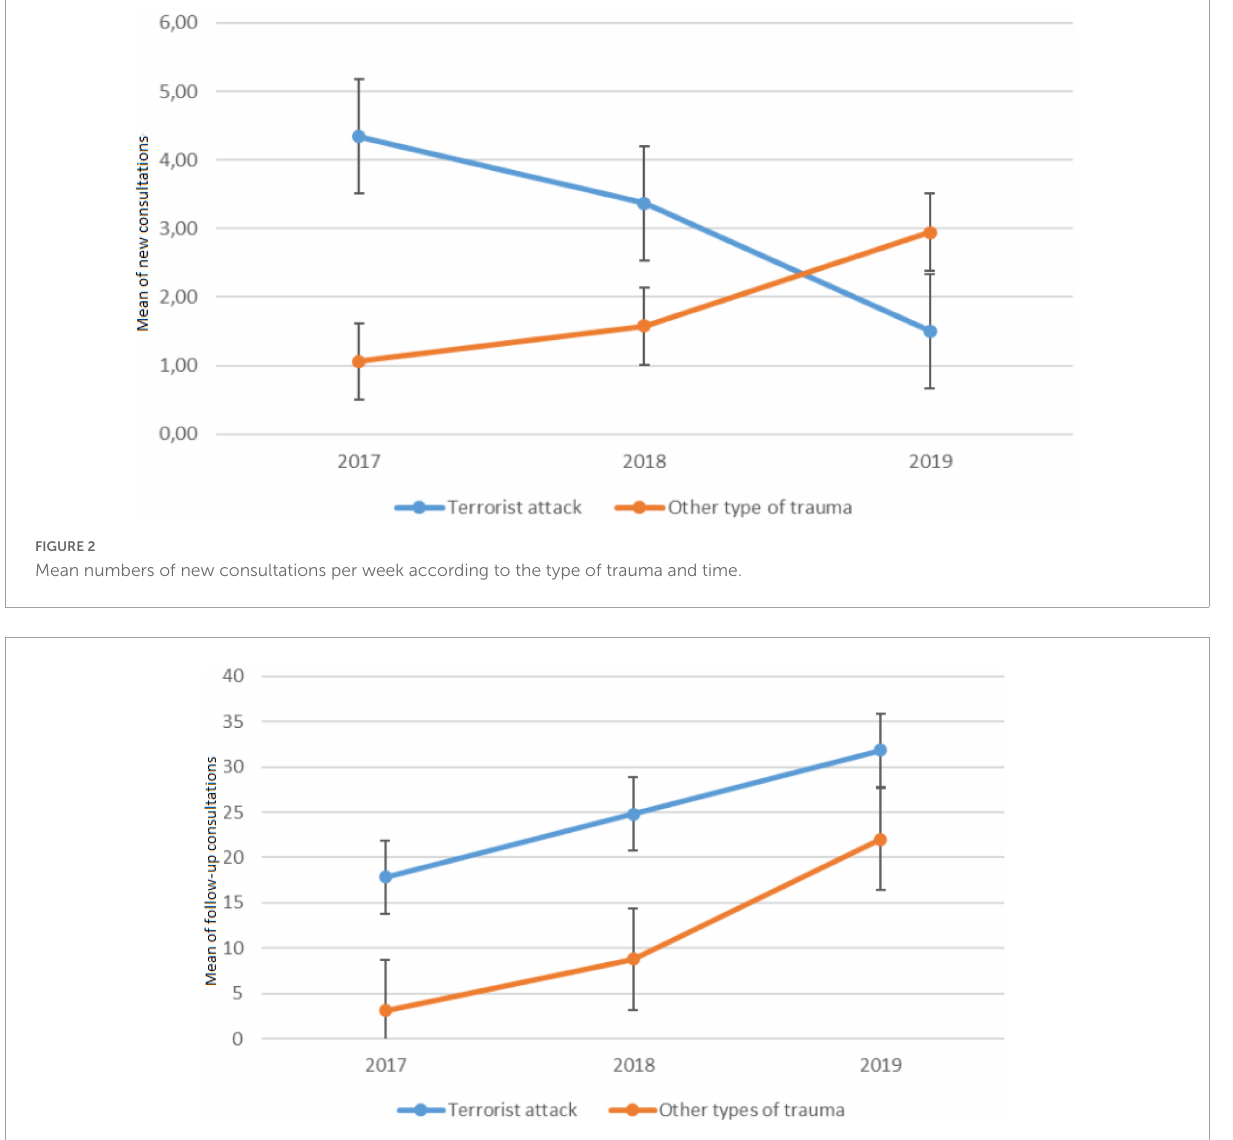
FIGURE3 Mean number of follow-up consultations per week according to the traumatic event and